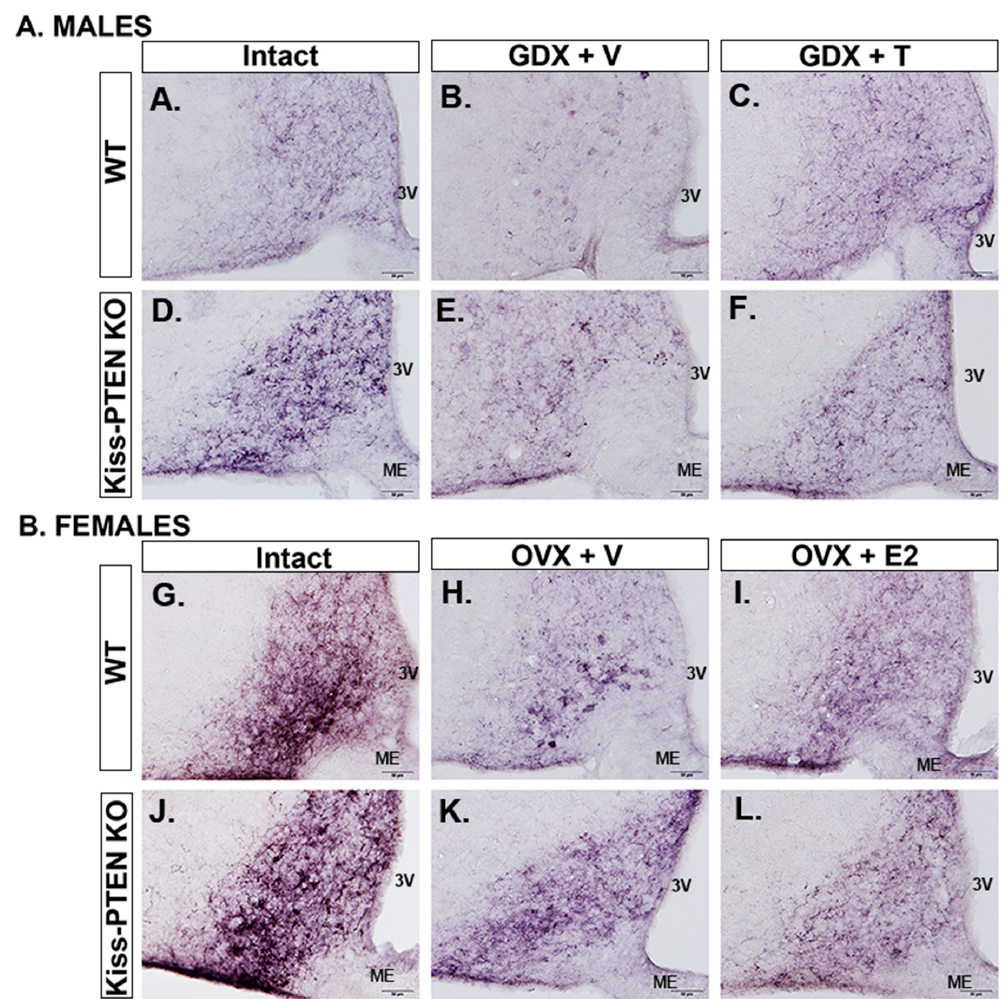
Figure 4. ARC kisspeptin-ir is not affected by gonadectomy in Kiss-PTEN KO males and females. Representative images showing kisspeptin-ir fiber plexus in the ARC of WT and Kiss-PTEN KO males ( A – F ) and females ( G – L ). Animals were either gonad-intact, gonadectomized treated with vehicle (GDX+V, males; OVX+V, females), or with steroid hormone replacement (GDX+T, males; OVX+E2, females). Scale bar = 100 μ m. 3V, third ventricle, ME, median eminence.